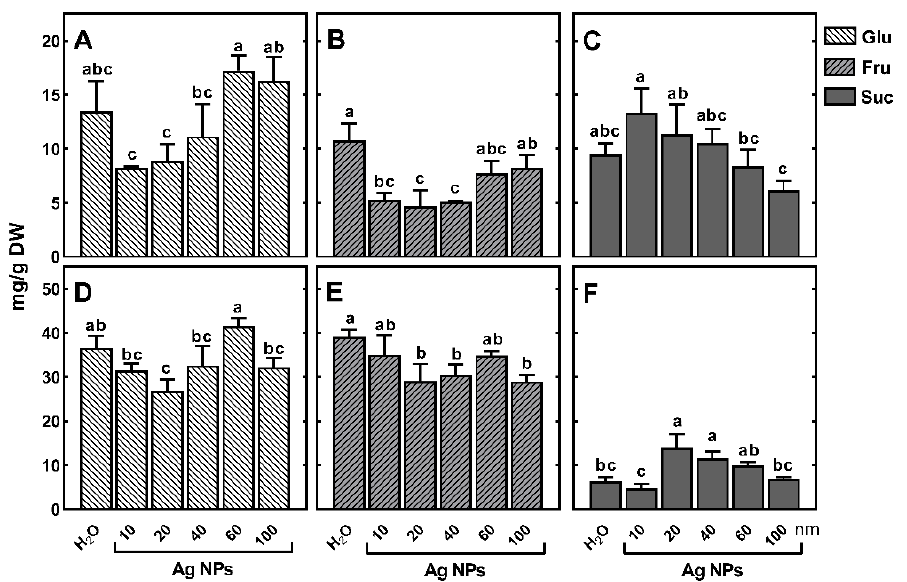
Figure 7. The effect of various sized Ag NPs citrate-stabilized nanoparticles in the range of 10–100 nm on the concentration of glucose (Glu), fructose (Fru), and sucrose (Suc) in roots ( A – C ) and coleoptile ( D – F ) of 3-day-old seedlings of wheat ( Triticum aestivum L. cv. ‘Ostka Strzelecka’). Control grains were germinated in double distilled water. Values are means ( n = 3) + SD. Bars with the same letters (a – c) are not significantly ( p < 0.05) different after the ANOVA test and Tukey’s post hoc corrections.